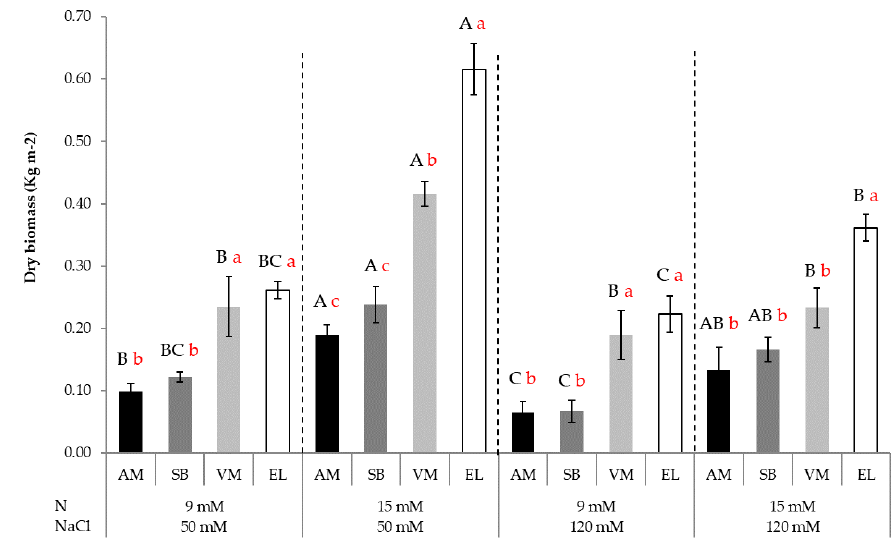
Figure 2. Dry shoot biomass in Arthrocnemum macrostachyum (AM), Salicornia brachiata (SB), and Sarcocornia fruticosa ecotypes (EL and VM). LN under different combinations of N (9 and 15 mM) and NaCl (50 and 120 mM). Means plus standard errors (±SE) are shown. Different uppercase letters show significant differences between treatments of one ecotype (same color bars), and different lowercase red letters show significant differences between ecotypes within the same treatment (Tukey’s HSD, p ≤ 0.05, n = 4).